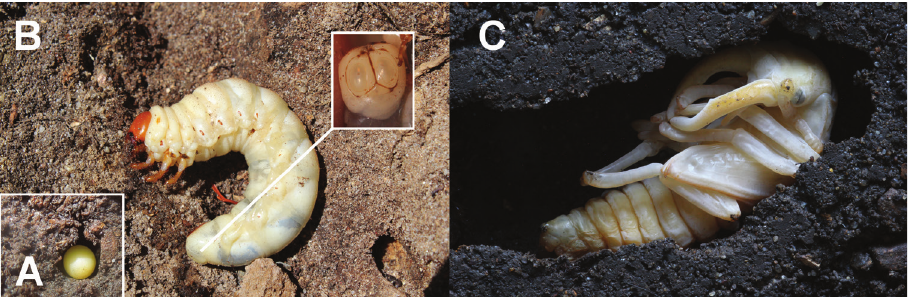
Figure 3. Pre-imaginal stages of Lucanus cervus : A egg (photo by C. Molls) B mature larva in lateral view (photo by M. Przewoźny) and detail of the apex of the abdomen in posterior view (photo by M. Fremlin) C Pupa of a male in lateral view (photo by M. Fremlin).